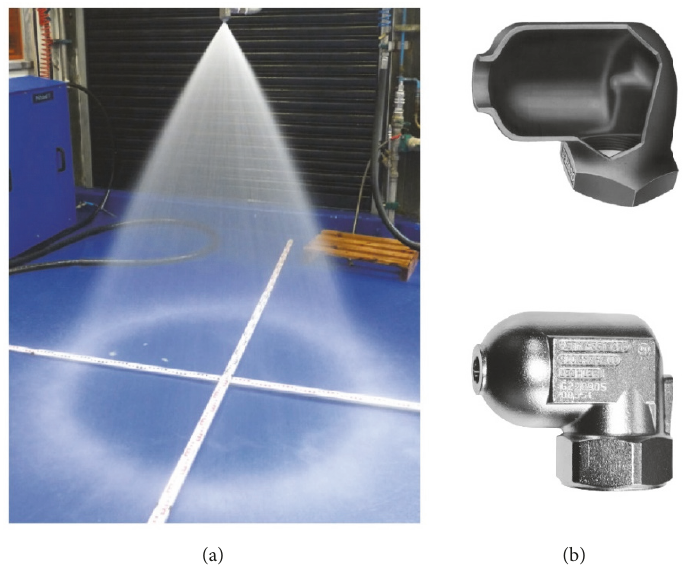
Figure 1: A design of hollow cone nozzle 1713-A by Lechler (b) and hollow cone spray pattern (a)